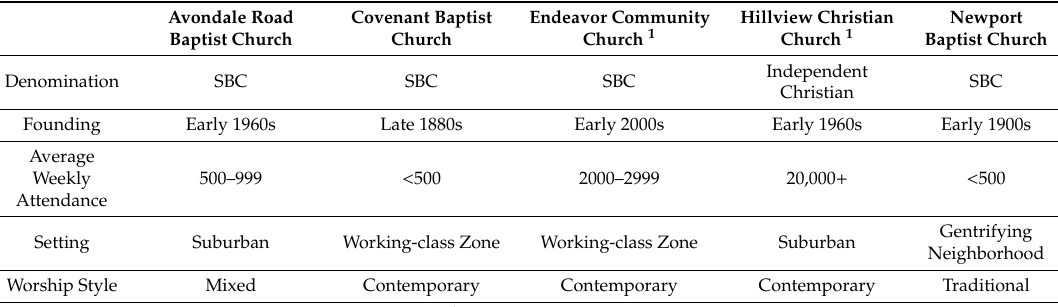
Table A1. Congregations in the Sample.